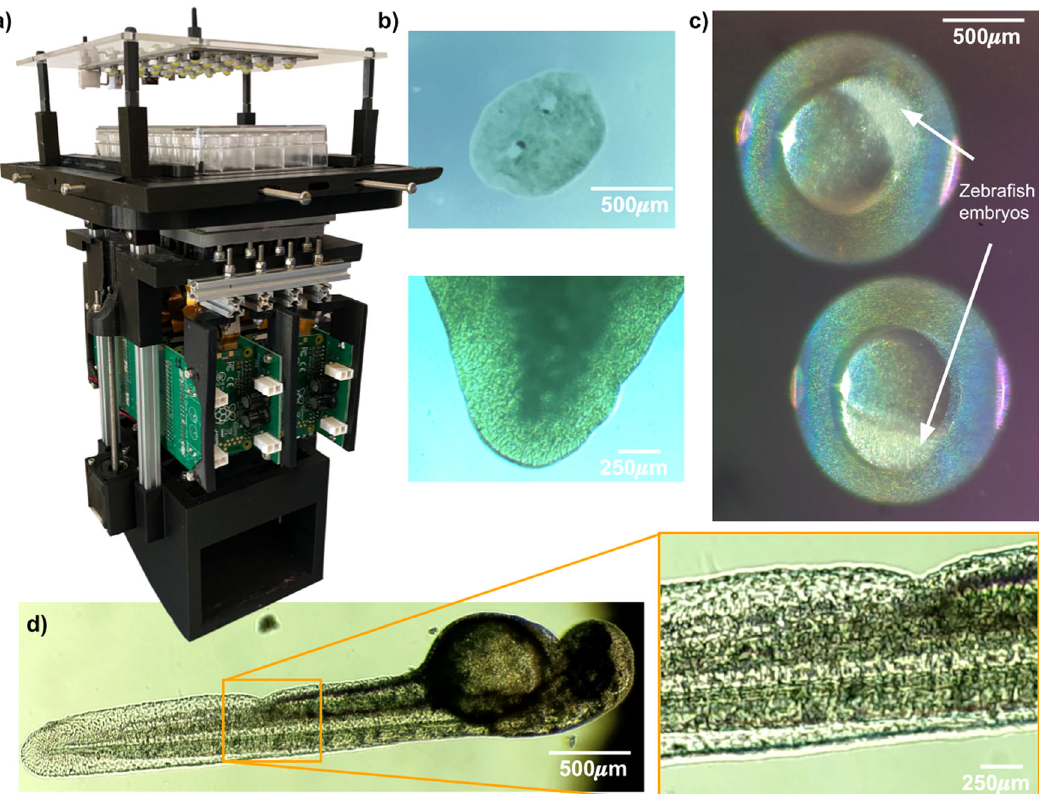
Fig. 1 Development of a low-cost system for simultaneous longitudinal biological imaging. a The Picroscope fi ts a standard 24-well plate, it is controlled remotely and images can be accessed through a web browser. b – d Applications of the Picroscope to longitudinal imaging of developmental biology and regeneration. b Regeneration of planaria worms Dugesia tigrina . c Zebra fi sh embryonic development at oblong stage. d Zebra fi sh embryo at 48 hours post fertilization. In complement see Supplementary Video